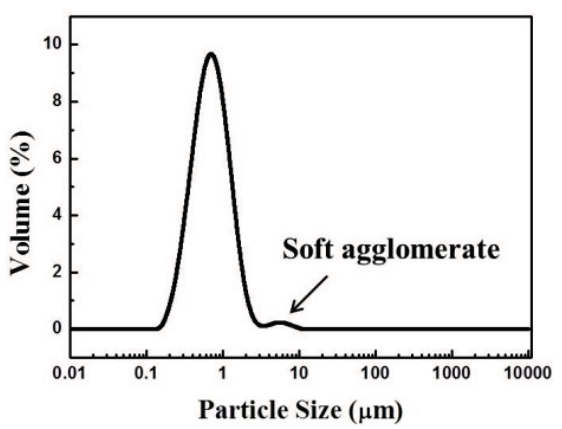
Figure 5. Particle size distribution of